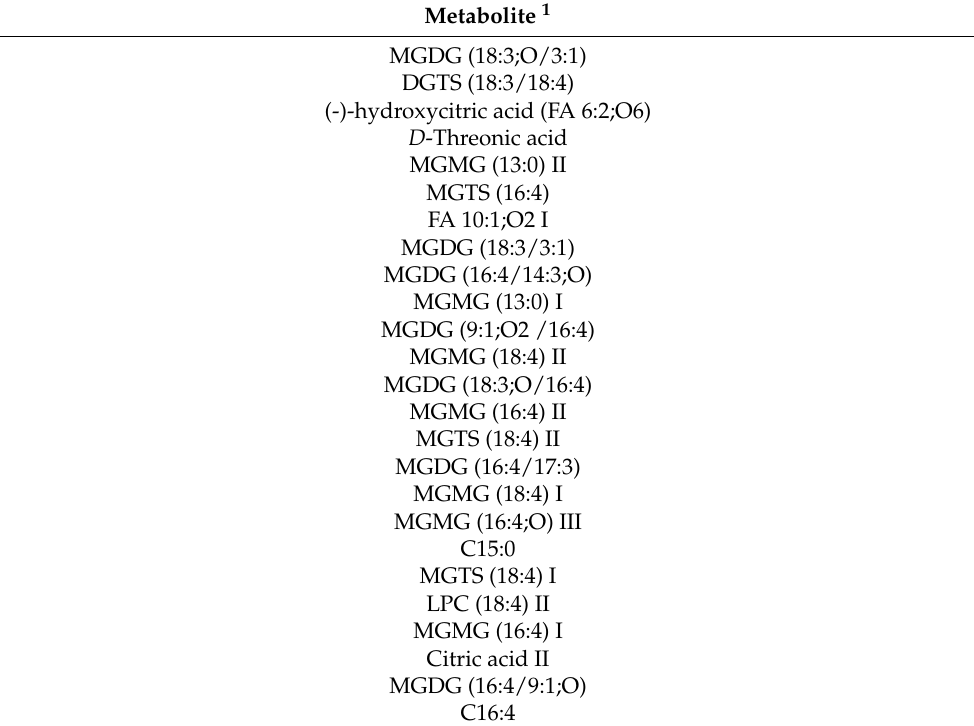
Table 7. Top 25 metabolites significant for discrimination between microalgae species based on Partial Least Squares Discriminant